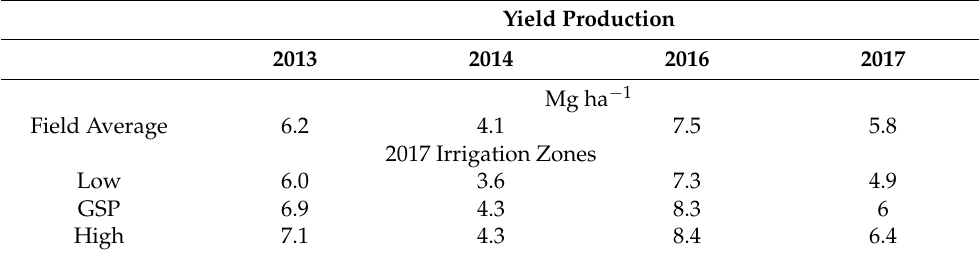
Table 4. Yield history for research site. The yield data is partitioned into 2017 irrigation treatments for all years even though irrigation was uniform before 2017 to demonstrate historic yield trends in these